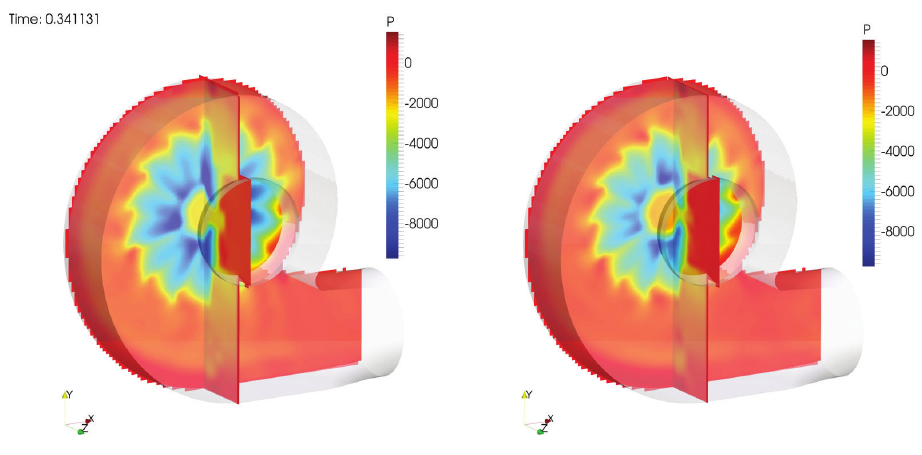
Figure 26 - Instantaneous field of pressure at t = 0:34s; left: original rotor; right: modified rotor.